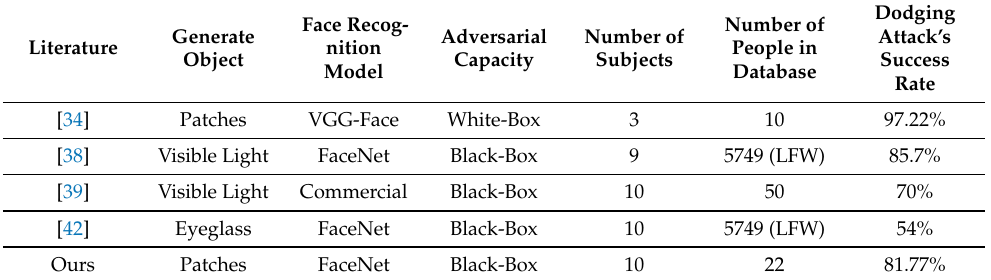
Table 13. Comparison of physical dodging attack success rates of different